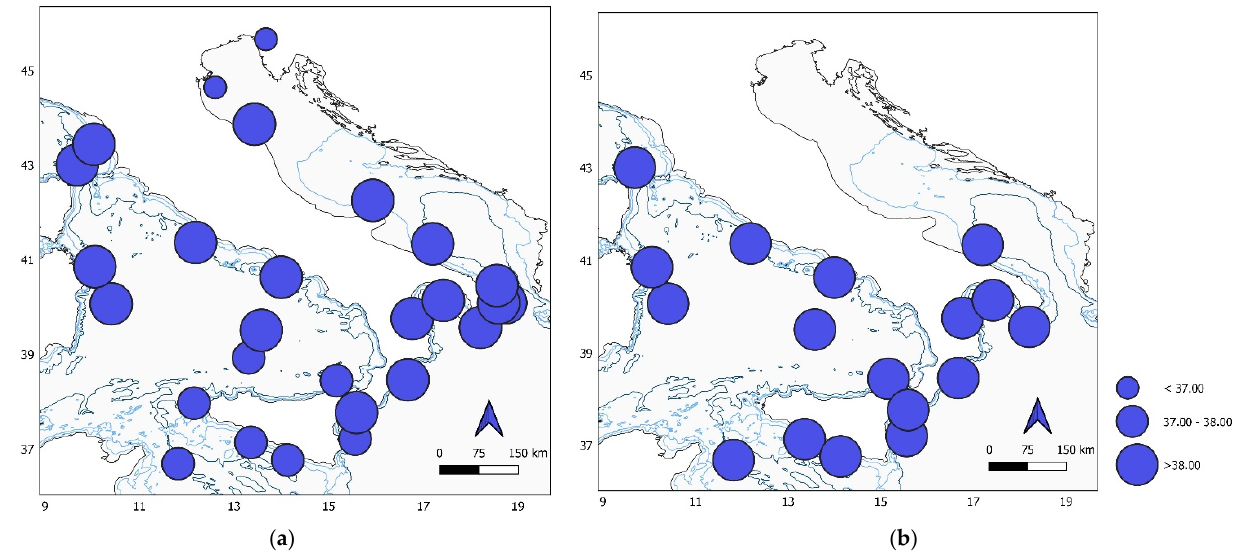
Figure 3. Map of the study area showing differences in salinity of ( a ) epipelagic and ( b ) mesopelagic stations.